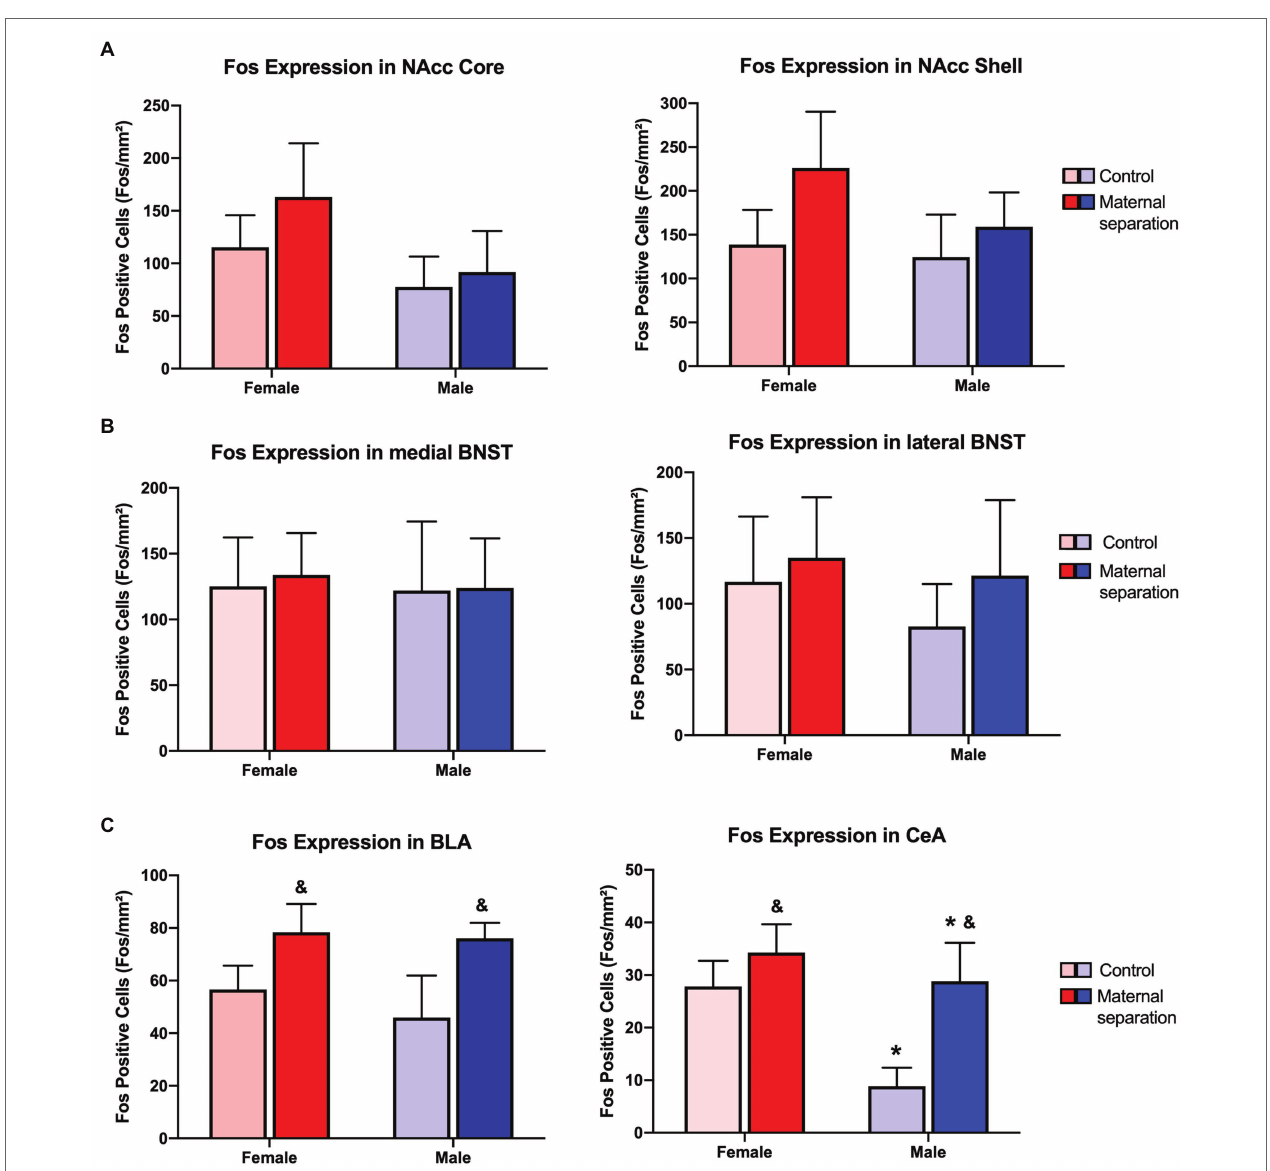
FIGURE 6 | Immunohistochemistry assay for Fos protein. Number of Fos-IR neurons presented as Fos positive cells per mm 2 in Nacc Core and Shell (A) , medial and lateral BNST (B) , and BLA e central amygdala (CeA; C ). N = 6–7/group. GLM analysis, data: mean ± SEM. &: MS stress > control, considering stress factor. *: male < female, considering sex